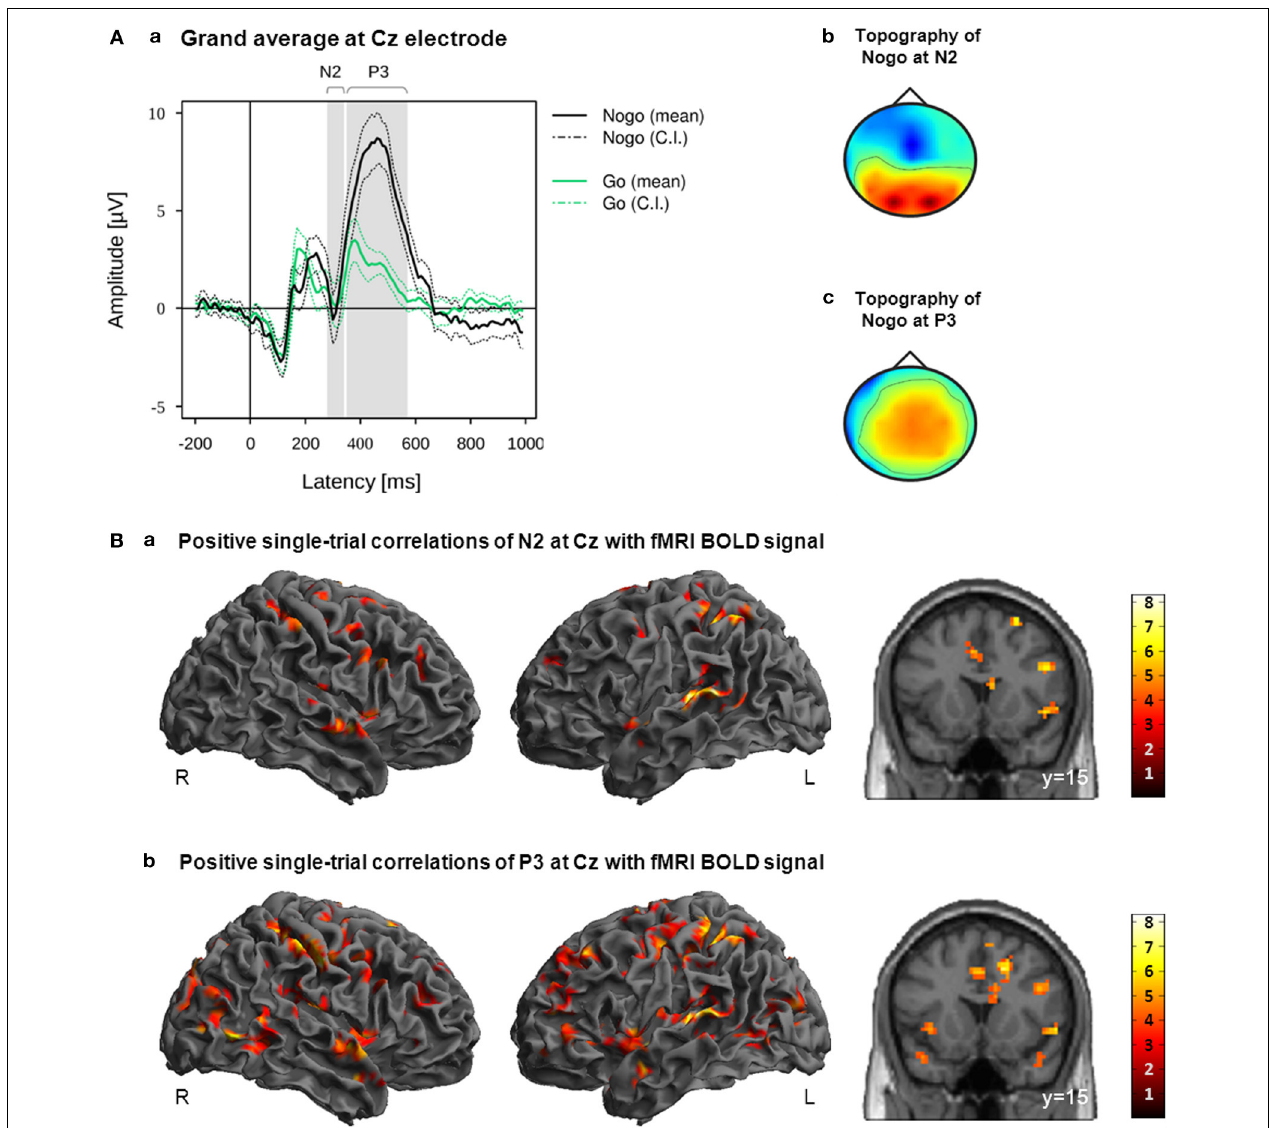
FIGURE 4 | (A) Grand average (a) and grand mean topographies at N2 latency range (b) and P3 latency range (c). Mean and 95% confidence interval (CI) of Nogo (black lines) and Go (green lines) are displayed in solid and dotted lines; gray bars indicate the early and late latency ranges on the group level (a). (B) Activation maps displaying the main effects of